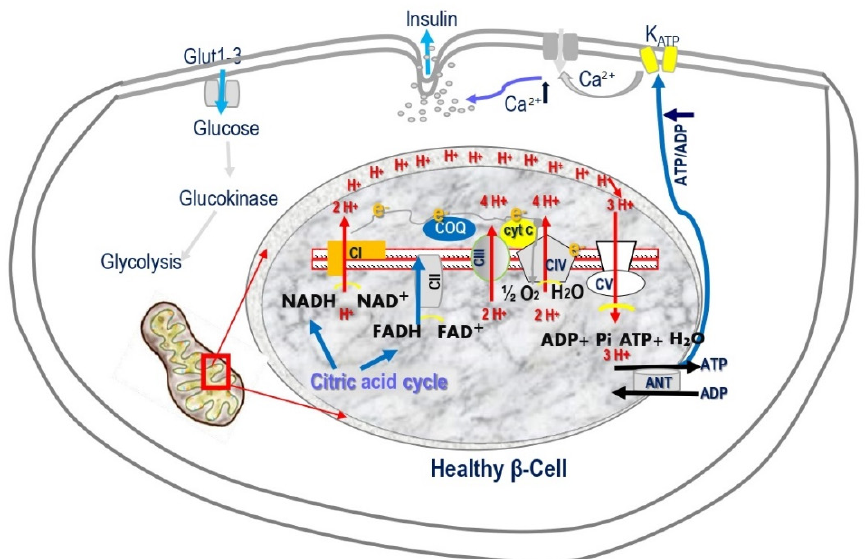
Figure 4. Mitochondrial oxidative phosphorylation (OXPHOS) is the only process that generates sufficient ATP to induce insulin secretion. OXPHOS is carried out by the mitochondrial respiration chain (MRC) located in the mitochondrial inner membrane. Electrons move between the four complexes and are transferred to oxygen by complex IV, cytochrome coxidase (COX). The free energy released pumps protons at complexes I, III, and IV to the intermembrane space, creating a proton gradient. At complex V, ATP synthase, protons diffuse along this electrochemical gradient to generate